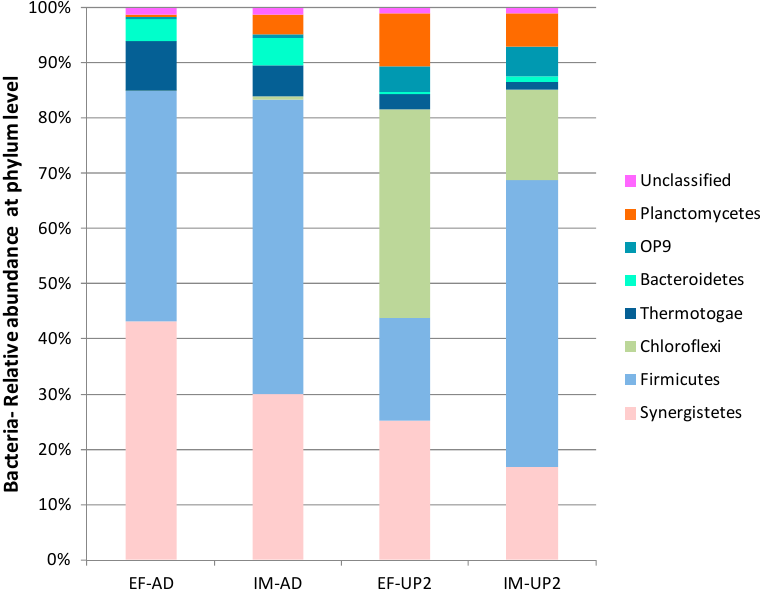
Figure 4. Relative abundances of the bacteria community at the phylum level at the end of AD (anaerobic digestion) and UP2 (H 2 injection) phases. Communities with a relative abundance ≥ 0.5% (in at least one sample) are reported. EF, effluent and IM, interstitial matrix. The microbial communities during the AD phase were dominated by Synergistetes (43% and 30% in EF and IM, respectively) and Firmicutes (42% and 53% in EF and IM, respectively). Representatives of Thermotogae and Bacteriodetes phyla were also abundant in microbial communities of the AD phase, representing 9% and 4% in the EF sample and 6% and 5% in the IM sample, respectively. Minor representative phyla in the AD phase were identified only in the IM sample, i.e., Planctomycetes (4%), Chloroflexi (1%), and OP9 (1%). After H 2 injection, relevant changes in the microbial community structures were observed both for effluent and interstitial matrix samples. The Synergistetes and Firmicutes phyla still represented a considerable fraction of UP2 communities, although their relative abundance decreased considerably as compared with the AD samples. In particular, in the EF-UP2 samples, Synergistetes represented 25% of the bacterial community, while Firmicutes represented 19%. A different trend was observed in the IM-UP2 sample, in which the abundance of Synergistetes further decreased to 17%, while the Firmicutes accounted for 51% of the whole community. The high increase in the relative abundance of Chloroflexi phylum was the most relevant observed change affecting the microbial community structure during the UP2 phase. Representatives of this phylum accounted for 37% and 16% of the bacterial community in EF-UP2 and IM-UP2 samples, respectively. Moreover, an increase in the relative abundances of Planctomycetes (9% and 6% in EF and IM, respectively) and OP9 (5% and 5% in EF and IM, respectively) was also observed. In contrast, the relative